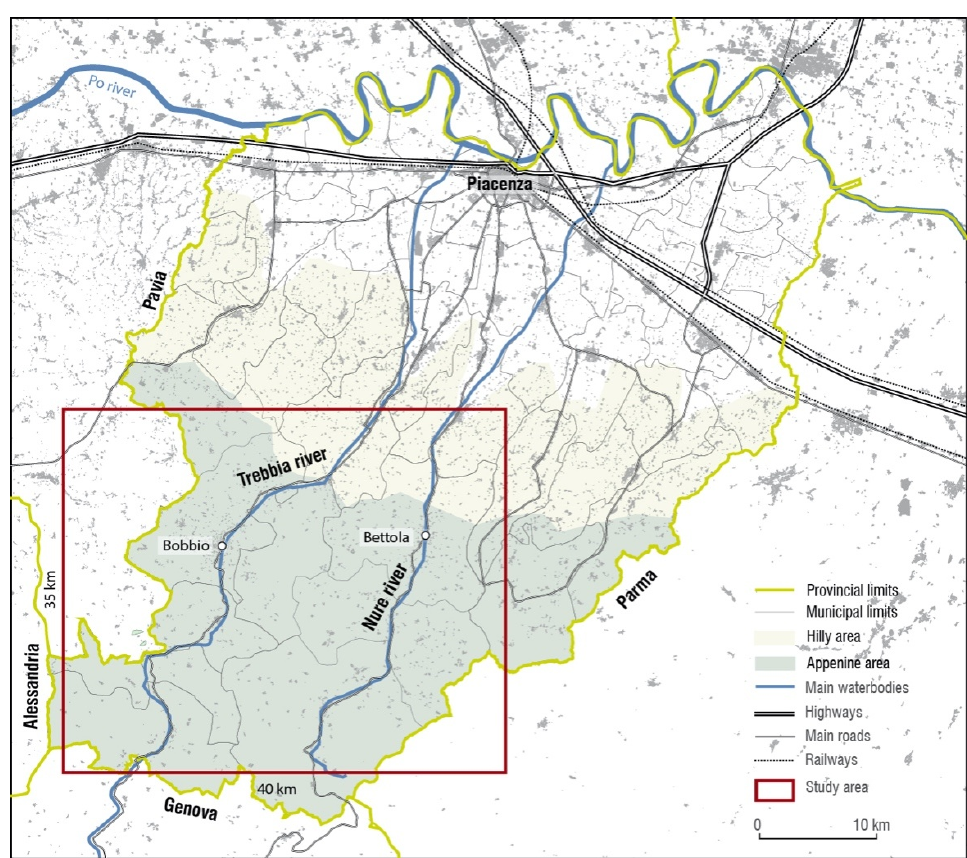
Figure 1: The province of Piacenza and the study